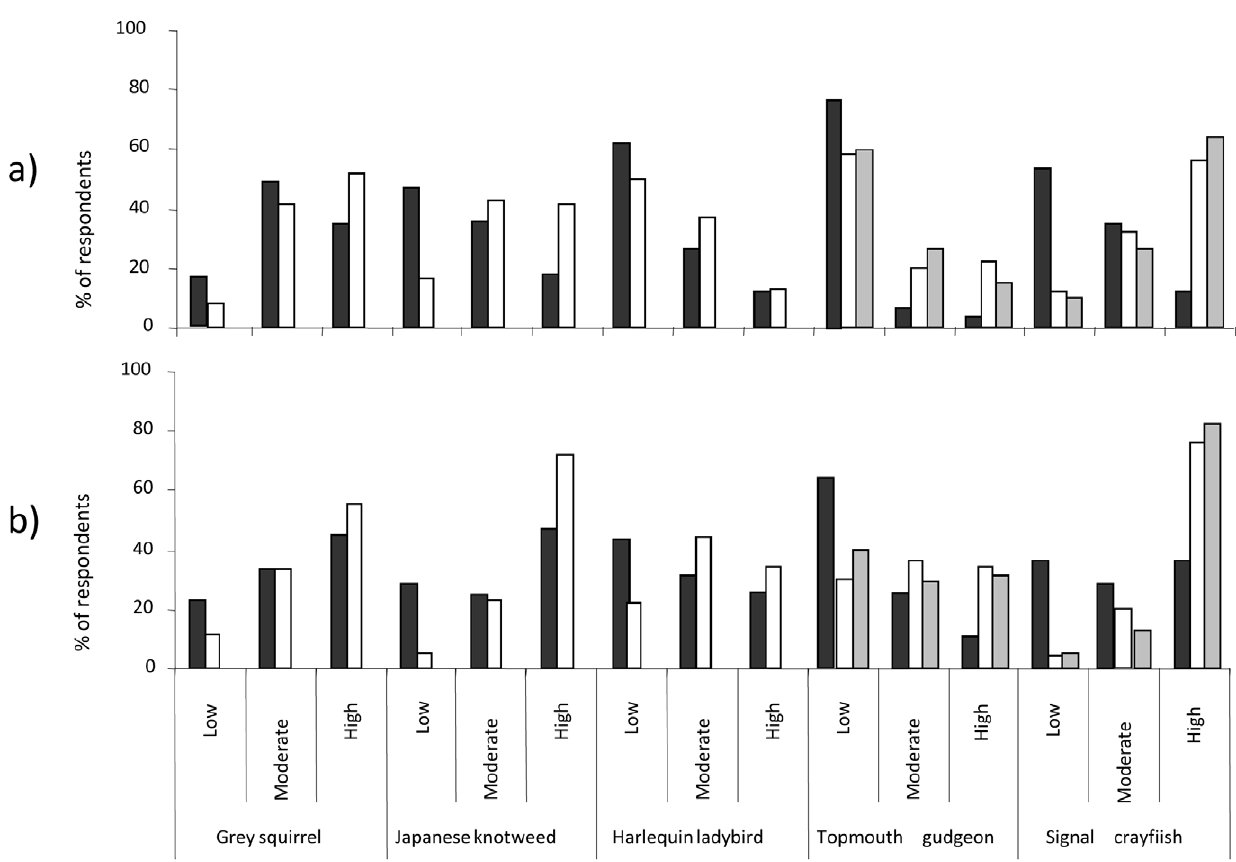
Figure 3. Evaluation of knowledge and threat perception concerning non-native species in the UK. (a) Knowledge (%) and (b) threat perception (%) of non-native species in the UK by the public (black; n=186), conservation managers (white; n=132) and anglers (grey; n=103).